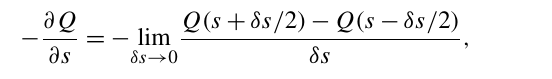
Figure 15. Vertical profiles of exchange flow ( u e ) and salinity ( S e ) at the deepest part of the Galveston Bay mouth averaged over days 250–300 for three numerical